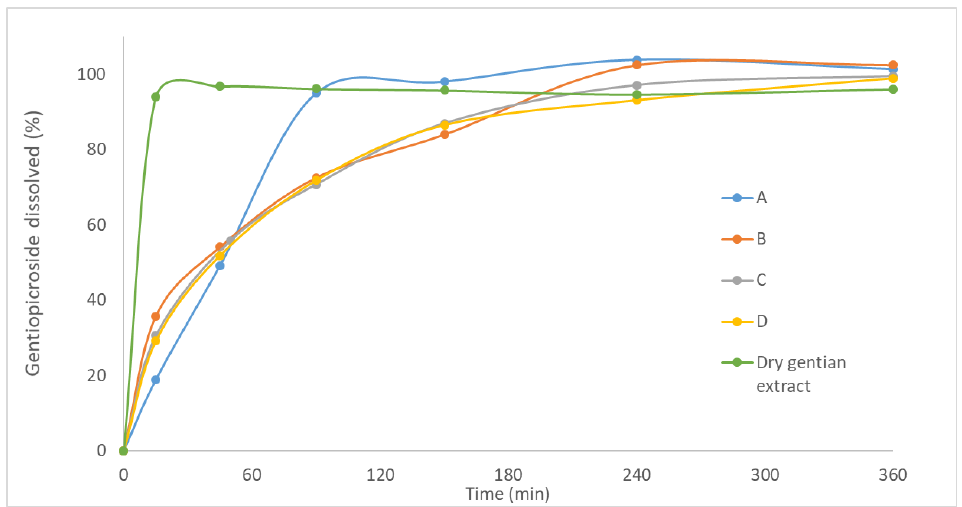
Figure 6. The dissolution profile of gentiopicroside from investigated formulations (A–D) of tablets and dry gentian extract powder.